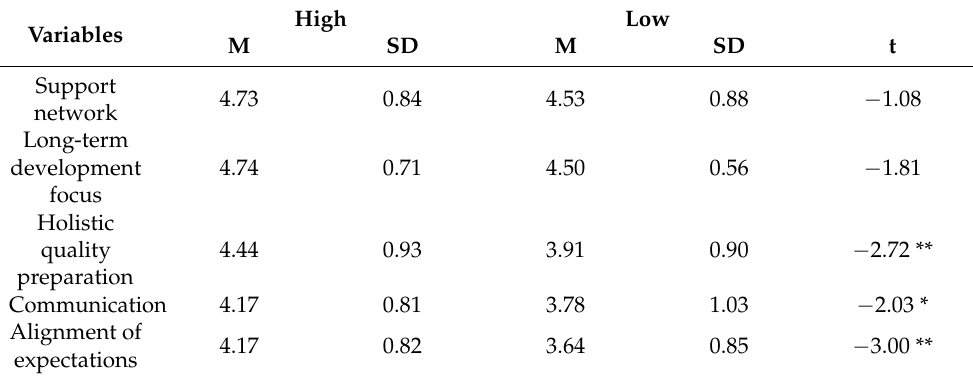
Table 1. Mean Value for the Five Dimensions in TDEQ-5 and Group Differences Among the Five Dimensions Comparing the Top-Five and Bottom-Five